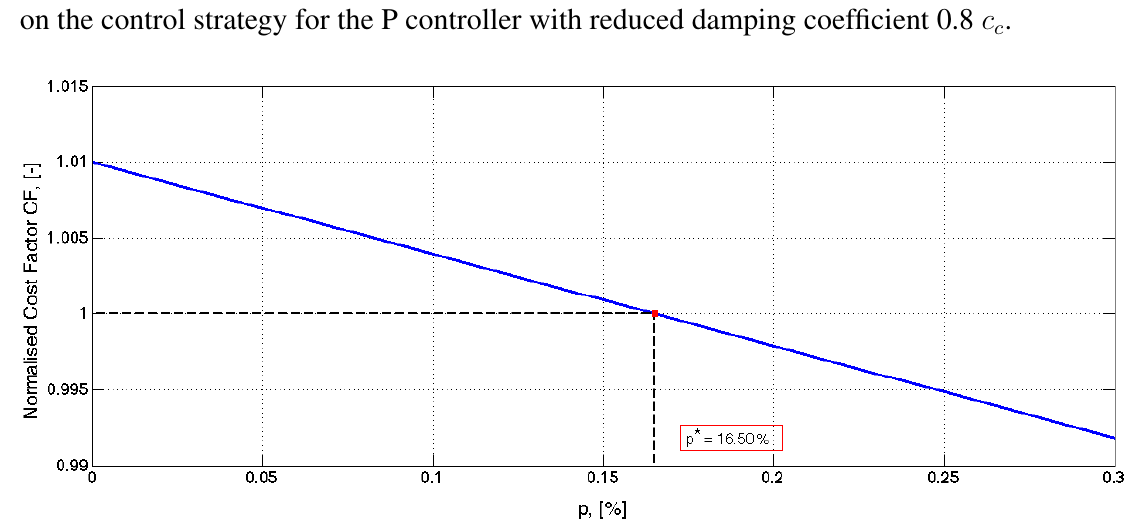
Figure 13. Variation of the cost factor with respect to the percentage of the cost depending on the control strategy for the P controller with reduced damping coefficient 0.8 c